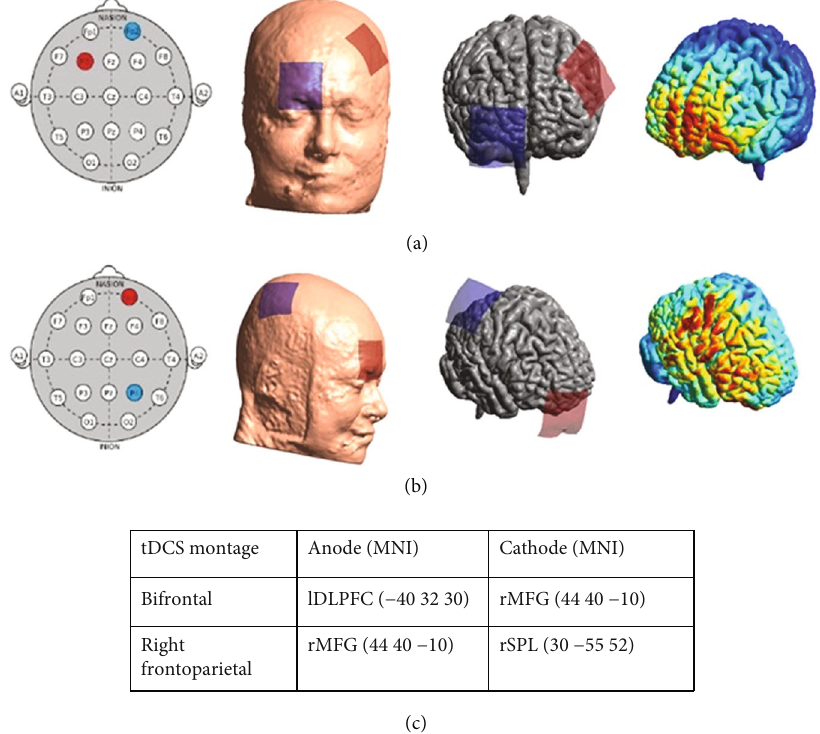
Figure 4: (a, b) Anode and cathode placements for bifrontal and right frontoparietal tDCS montages, respectively, with example current density determined using SimNIBS modeling software [38]; (c) MNI ( x y z ) electrode-center coordinates for both tDCS